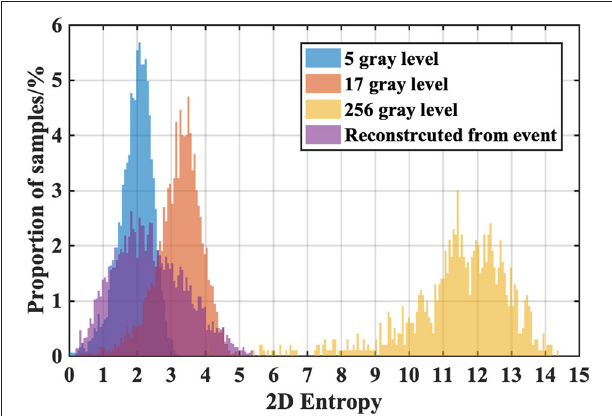
FIGURE 7 | 2D-Entropy histogram of the different compression levels of ILSVRC2012 sample groups and the reconstructed ES-ImageNet sample group. We compare the 2D-Entropy of four sample groups here. The reconstructed group indicates that the samples in ES-ImageNet potentially have effective information for object classification.